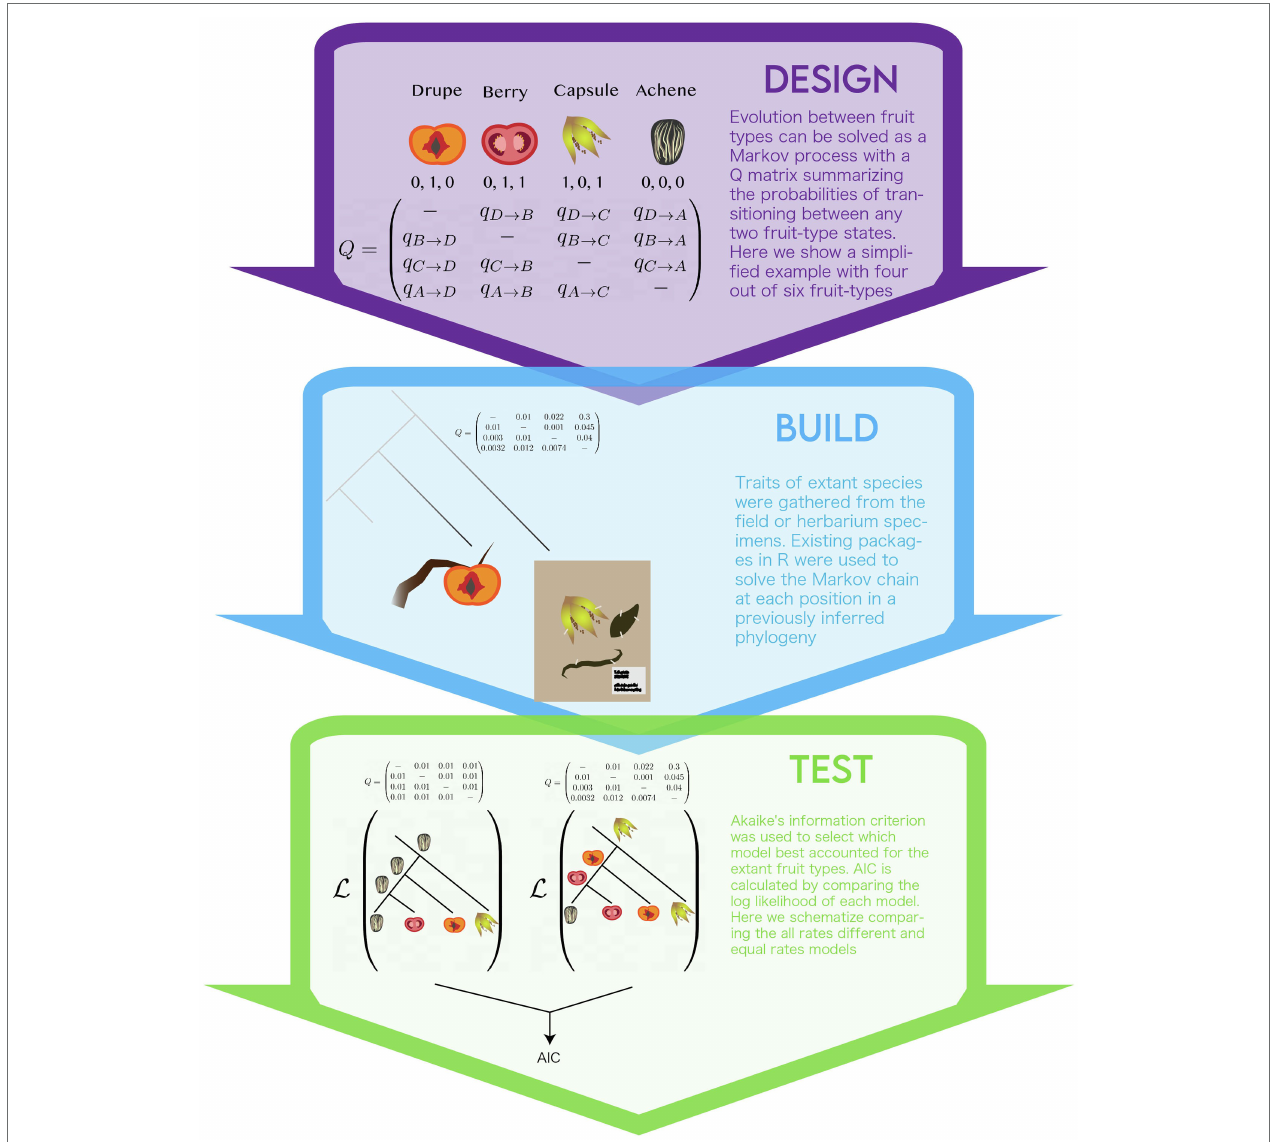
FIGURE 3 | The modeling life cycle used to implement the multistate model of the evolution of